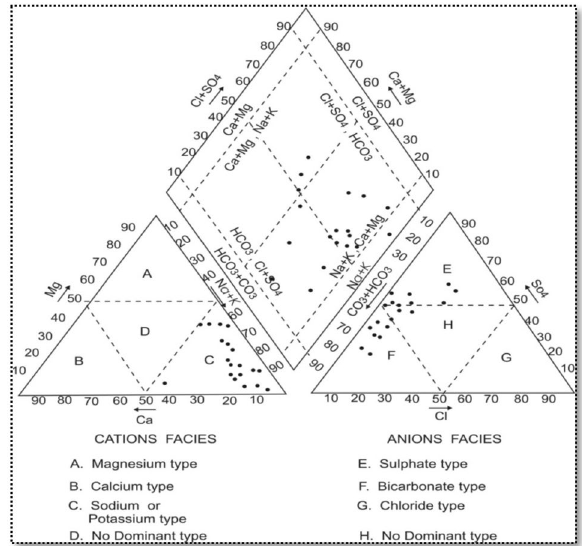
Fig. 6 Piper diagram for describing the hydro-chemical facies varia-